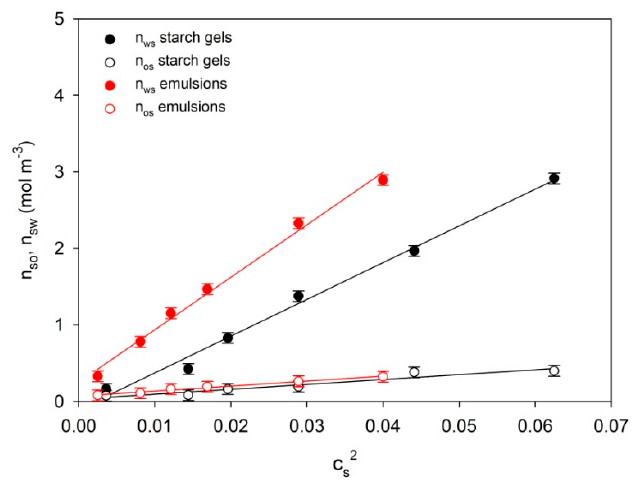
Figure 3. Concentrational relationships of initial n o and final n w concentrations of spatial network segments of the examined starch gels and starch–fat emulsions.